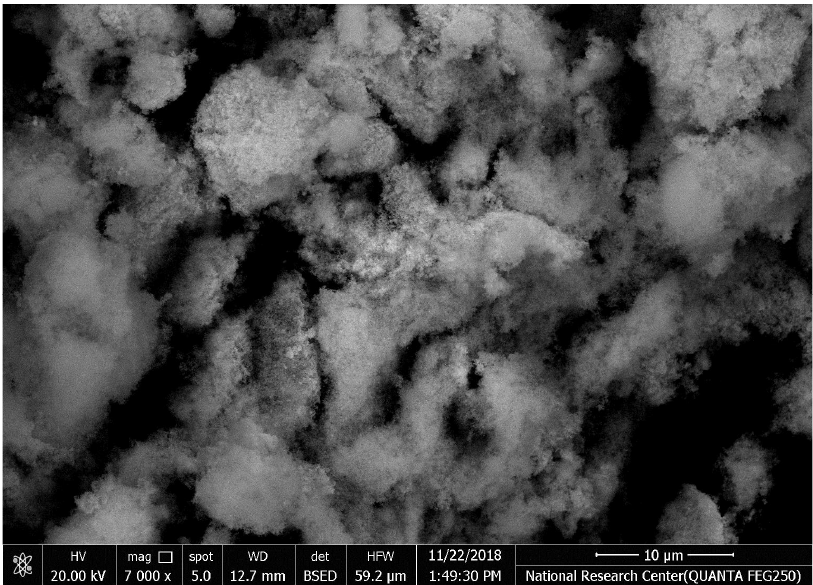
Figure 6. Scanning electron microscopy of hydroxyapatite nanoparticles (HAPNPs) with homogeneity 100 k zoom (energy 2.00 Kv).